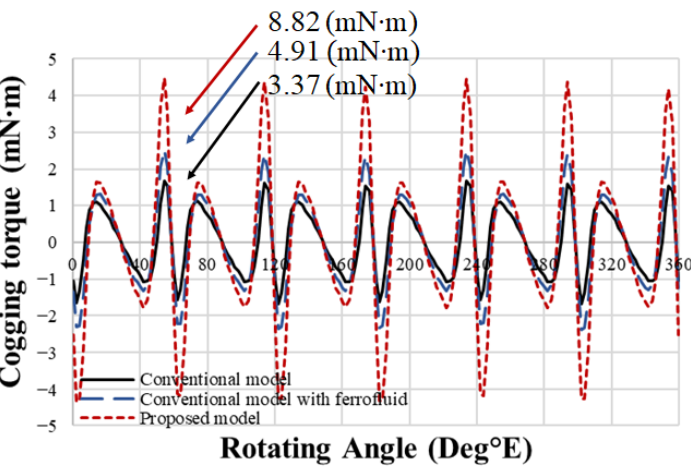
Figure 12. Comparison of the no-load back EMF (4000 rpm).